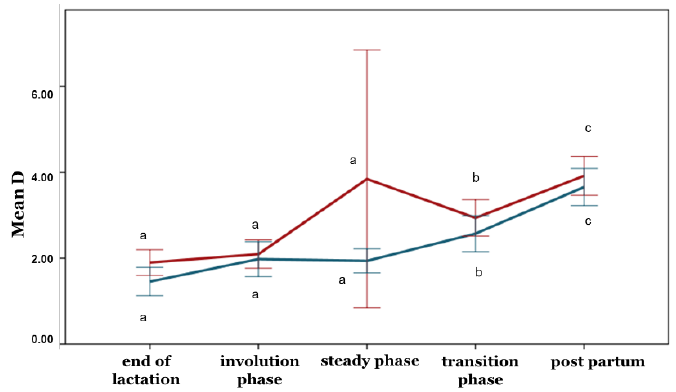
Figure 8. Mammary artery diameter changes among the periods and between the ewe groups ( p ≤ 0.05). The different letter indicators (a, b, c) represent statistically significant differences between the periods. The green line represents the ewe group with healthy udders, while the red represents the ewe group with subclinical mastitis.